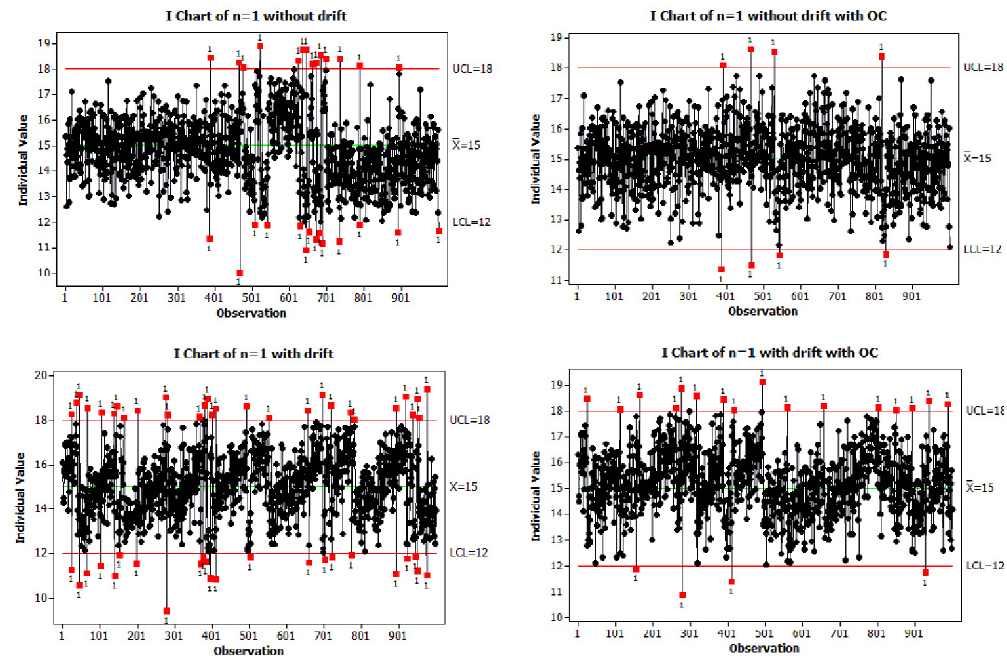
Fig. 6. n = 1 – Shewhart chart for the first 1000 simulations.